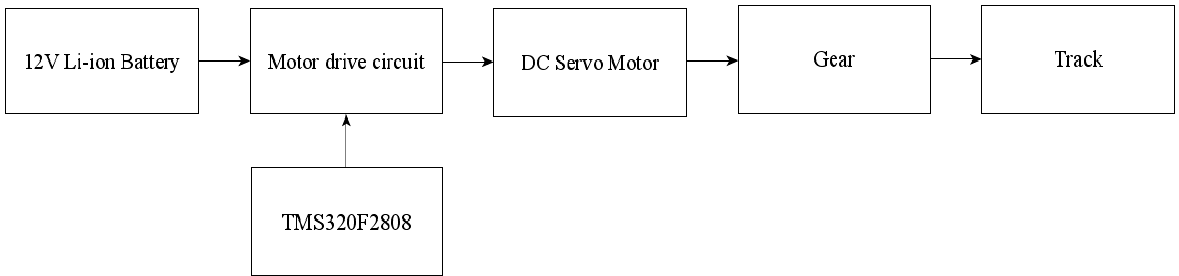
Figure 3. Motor drive system diagram.